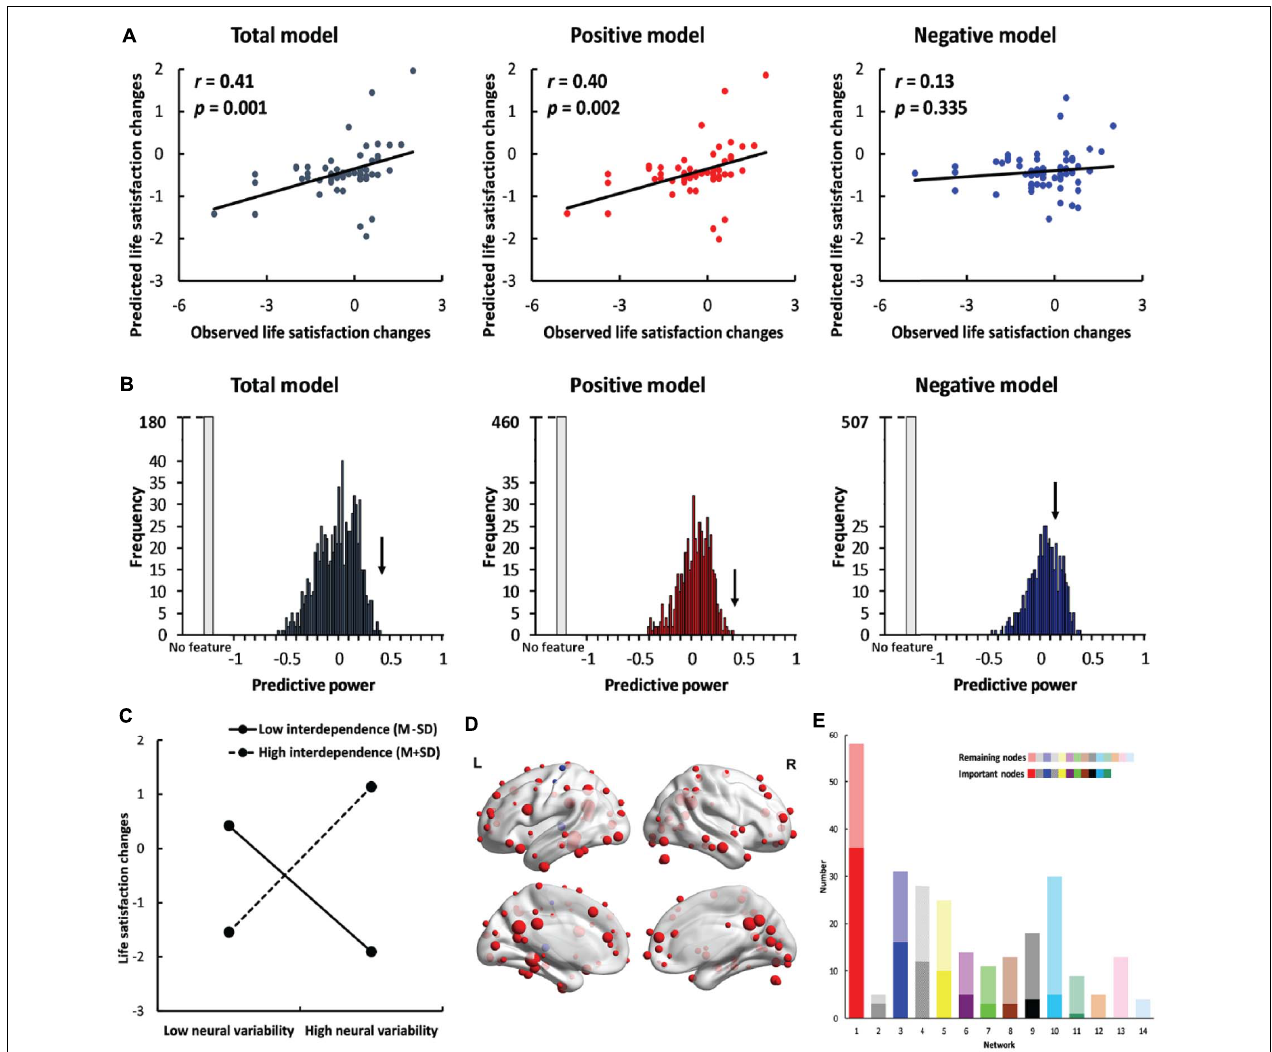
FIGURE 2 | Results of whole-brain prediction. (A) The predictive power (correlation between predicted life satisfaction change scores and observed life satisfaction change scores) of the total model ( left , dark gray), positive model ( middle , red) and negative model ( right , blue). (B) The results of permutation tests in the total model ( left , dark gray), positive model ( middle , red) and negative model ( right , blue). The black arrow indicates the observed predictive power in the three models. The light gray bar indicates the permutations in which no feature was selected in at least one iteration. (C) The simple effects of whole-brain prediction. (D) The location of important nodes (the nodes that were selected as features in more than 95% of the iterations) in the positive feature set (red) and in the negative feature set (blue). (E) The distribution of important nodes in the default mode network (red), memory retrieval network (gray), visual network (blue), uncertain network (striated), frontoparietal task control network (yellow), cingulo-opercular task control network (purple), dorsal attention network (green), subcortical network (brown), salience network (black), hand sensory-somatomotor network (cyan), ventral attention network (teal), mouth sensory-somatomotor network (orange), auditory network (pink) and cerebellar network (pale blue). The dark colors indicate the important nodes, and the light colors indicate the remaining nodes. The networks were ranked by the percentage of the number of important nodes out of all nodes in each specific